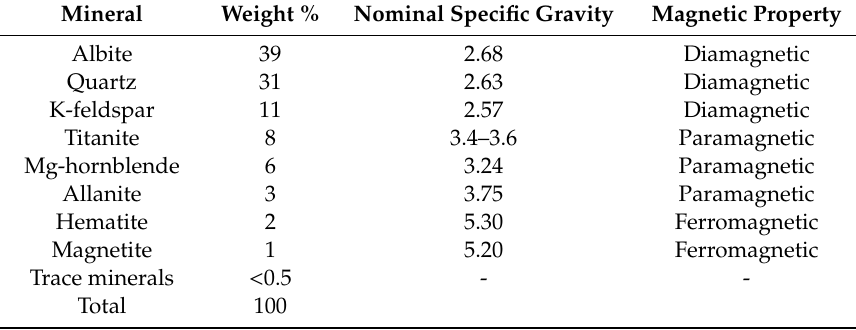
Table 2. Semiquantitative mineral contents of the composite sample (A-mixed), based on Reference Intensity Ratio (RIR) method. Specific gravity and magnetic property data from [44–46]. Mineral Weight % Nominal Specific Gravity Magnetic Property Albite 39 2.68 Diamagnetic Quartz 31 2.63 Diamagnetic K-feldspar 11 2.57 Diamagnetic Titanite 8 Allanite Hematite Magnetite 1 5.20 Ferromagnetic Trace minerals < 0.5 - - Total